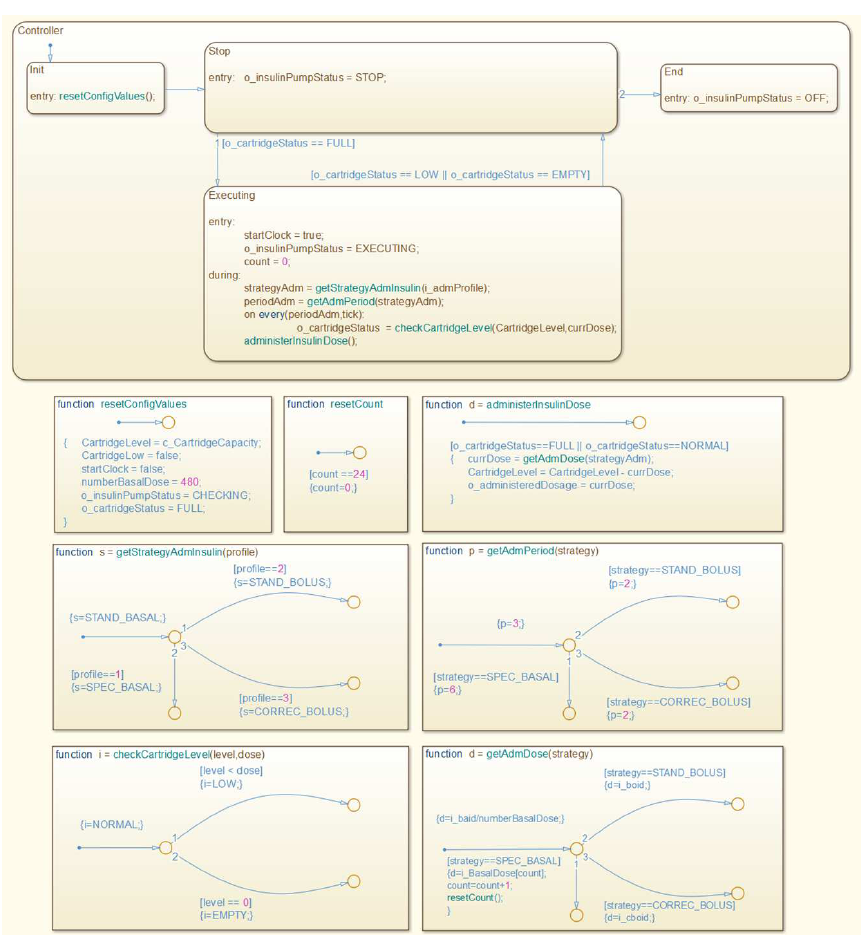
Figure 29. Insulin Pump Software Model in